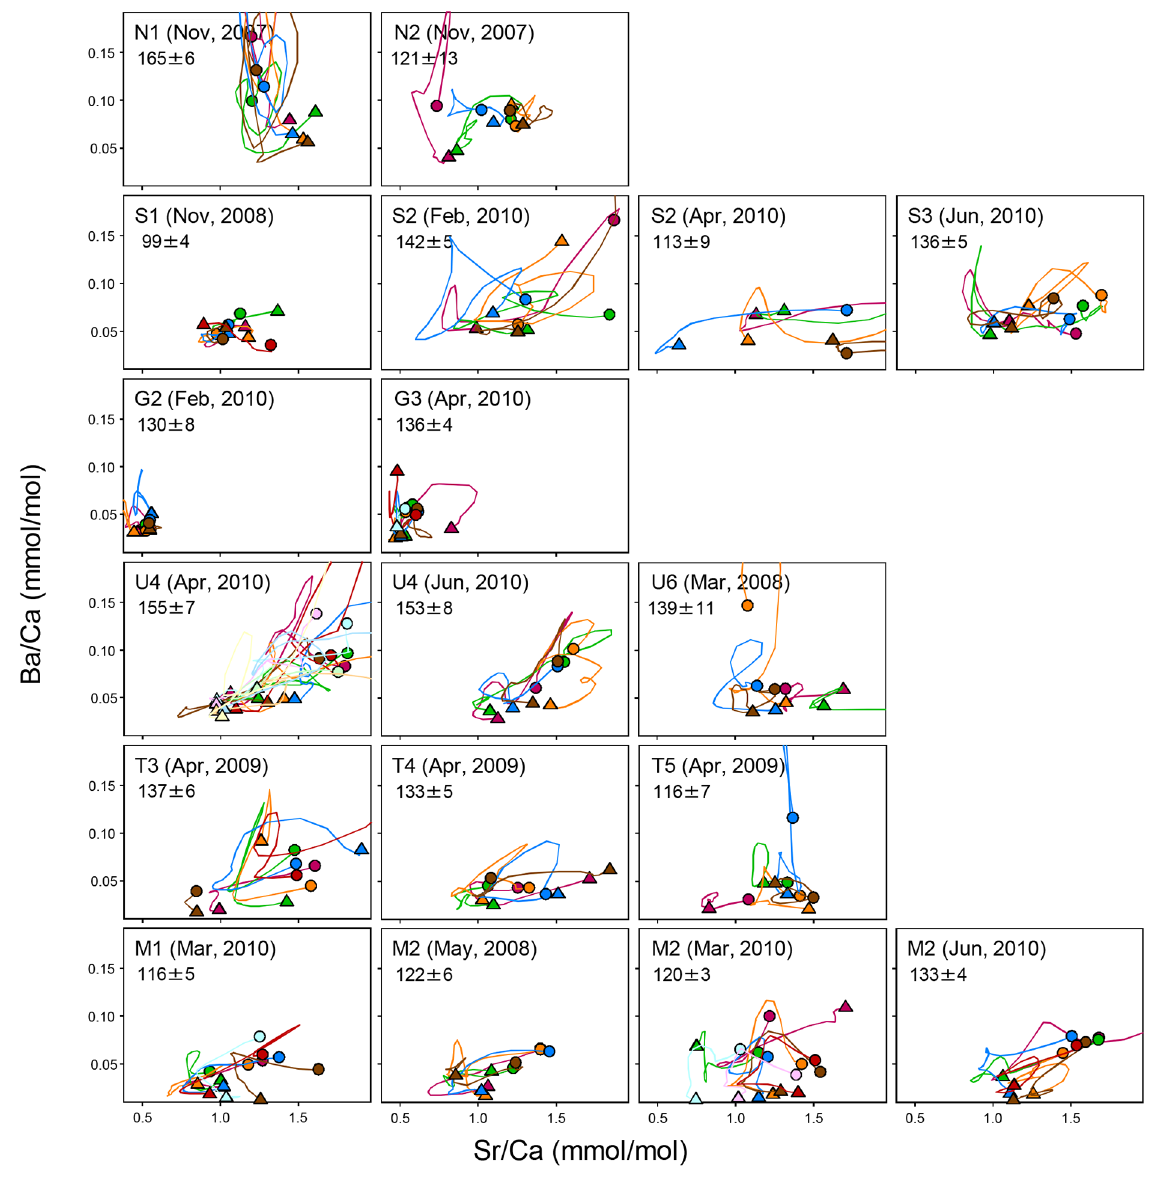
Figure 5. Sr-Ba elemental profiles along H.siamensis otolith transect. Triangle: otolith core. Circle: otolith surface. From top to bottom, otolith samples from Thai North (2), Songkhram (3), Gam (2), Mun (2), Tonle Sap (3), and Mekong mainstream (2) were analyzed with the number of sites in a parenthesis. Within a given site, different colors denote different individuals. doi:10.1371/journal.pone.0103722.g005 Table 3. Pairwise differences (mmol/mol) between regions in H. siamensis otolith surface elemental signatures for Sr/Ca (above diagonal) and Ba/Ca (below diagonal).